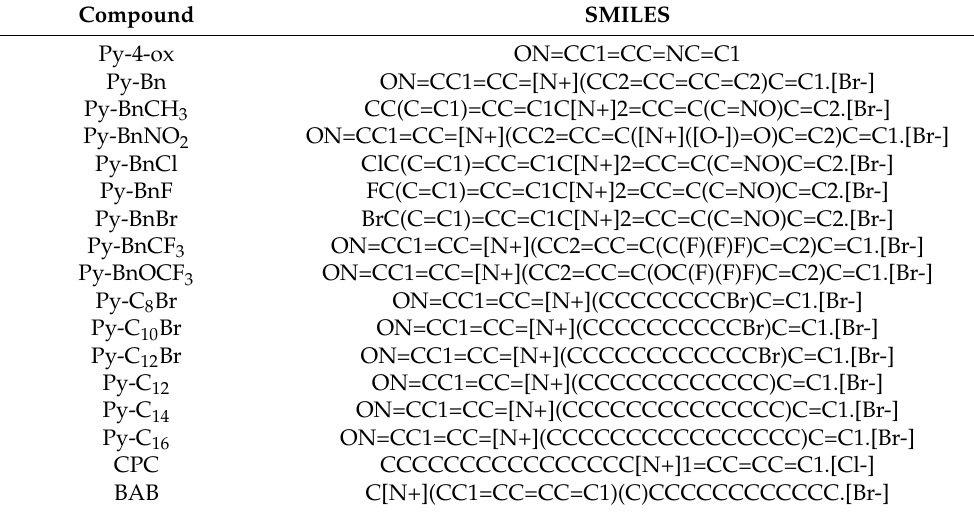
Table 5. Compound abbreviations and list of generated smiles used for ADME